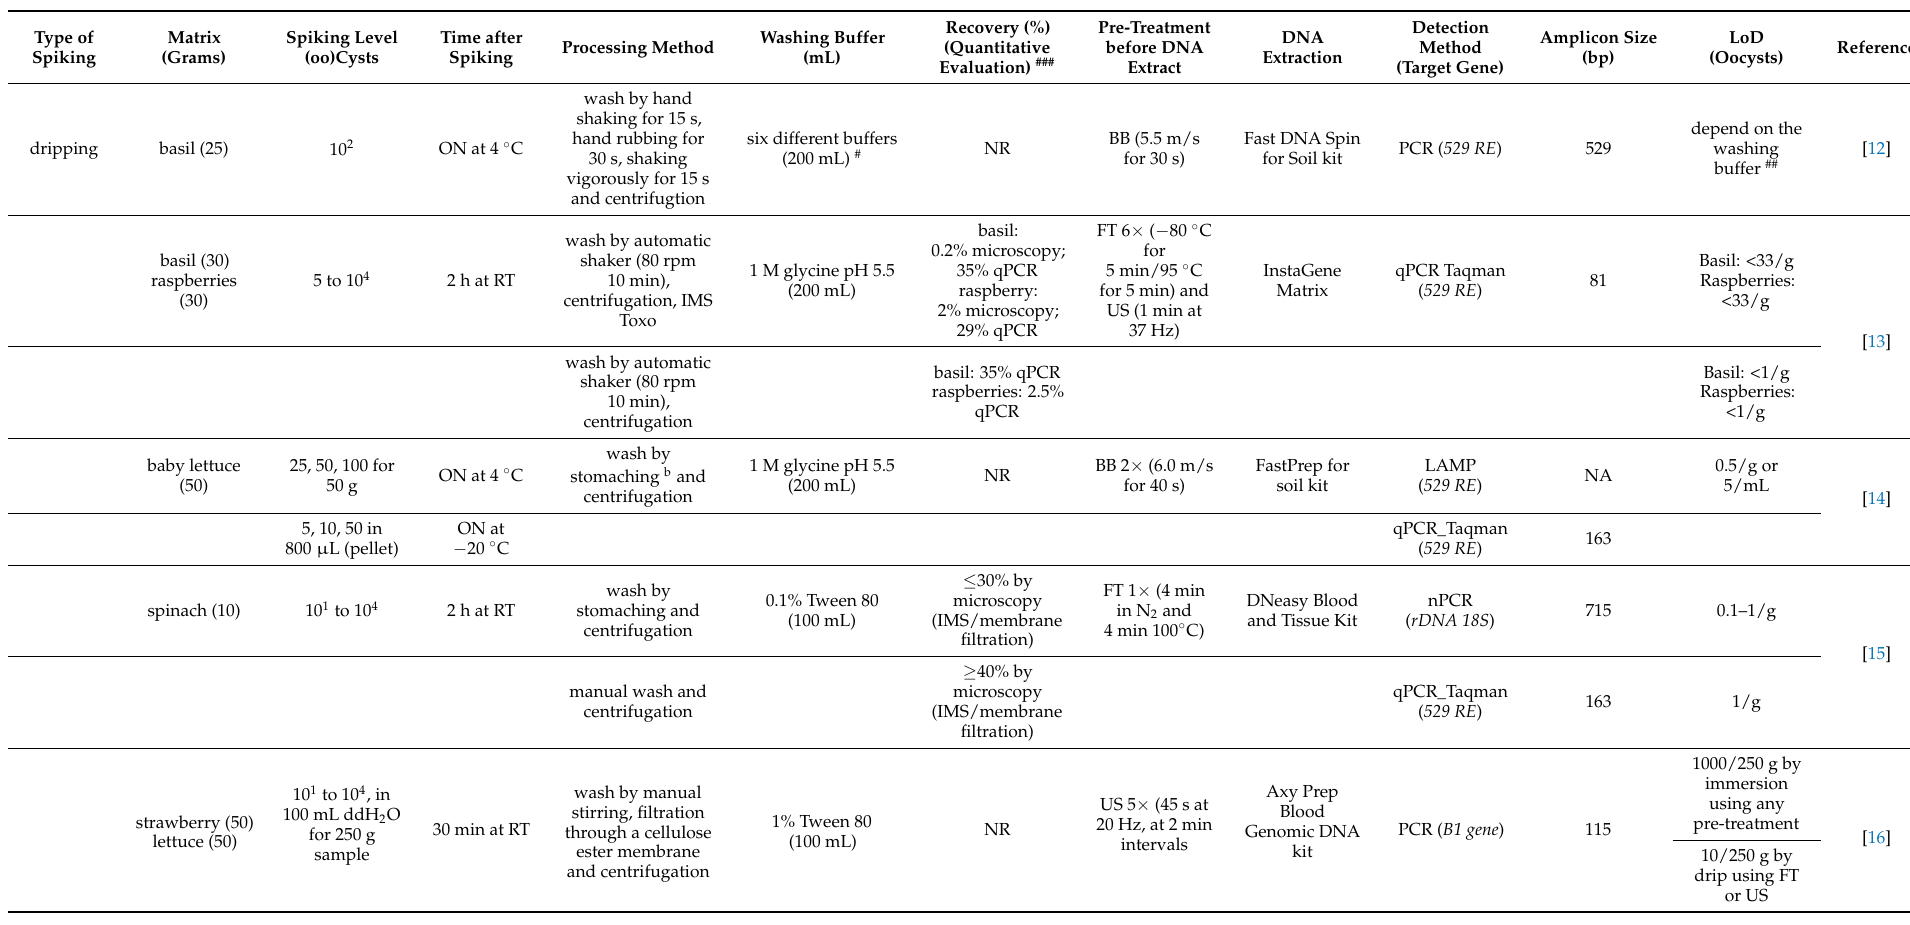
Table 1. Published methods for detection of Toxoplasma gondii in fresh produce that have been evaluated using spiking